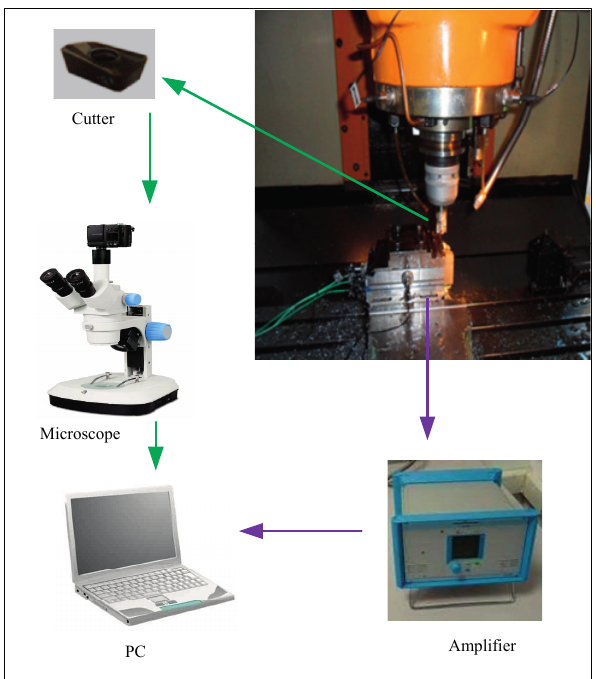
Figure 4. Scheme of tool wear experiment.